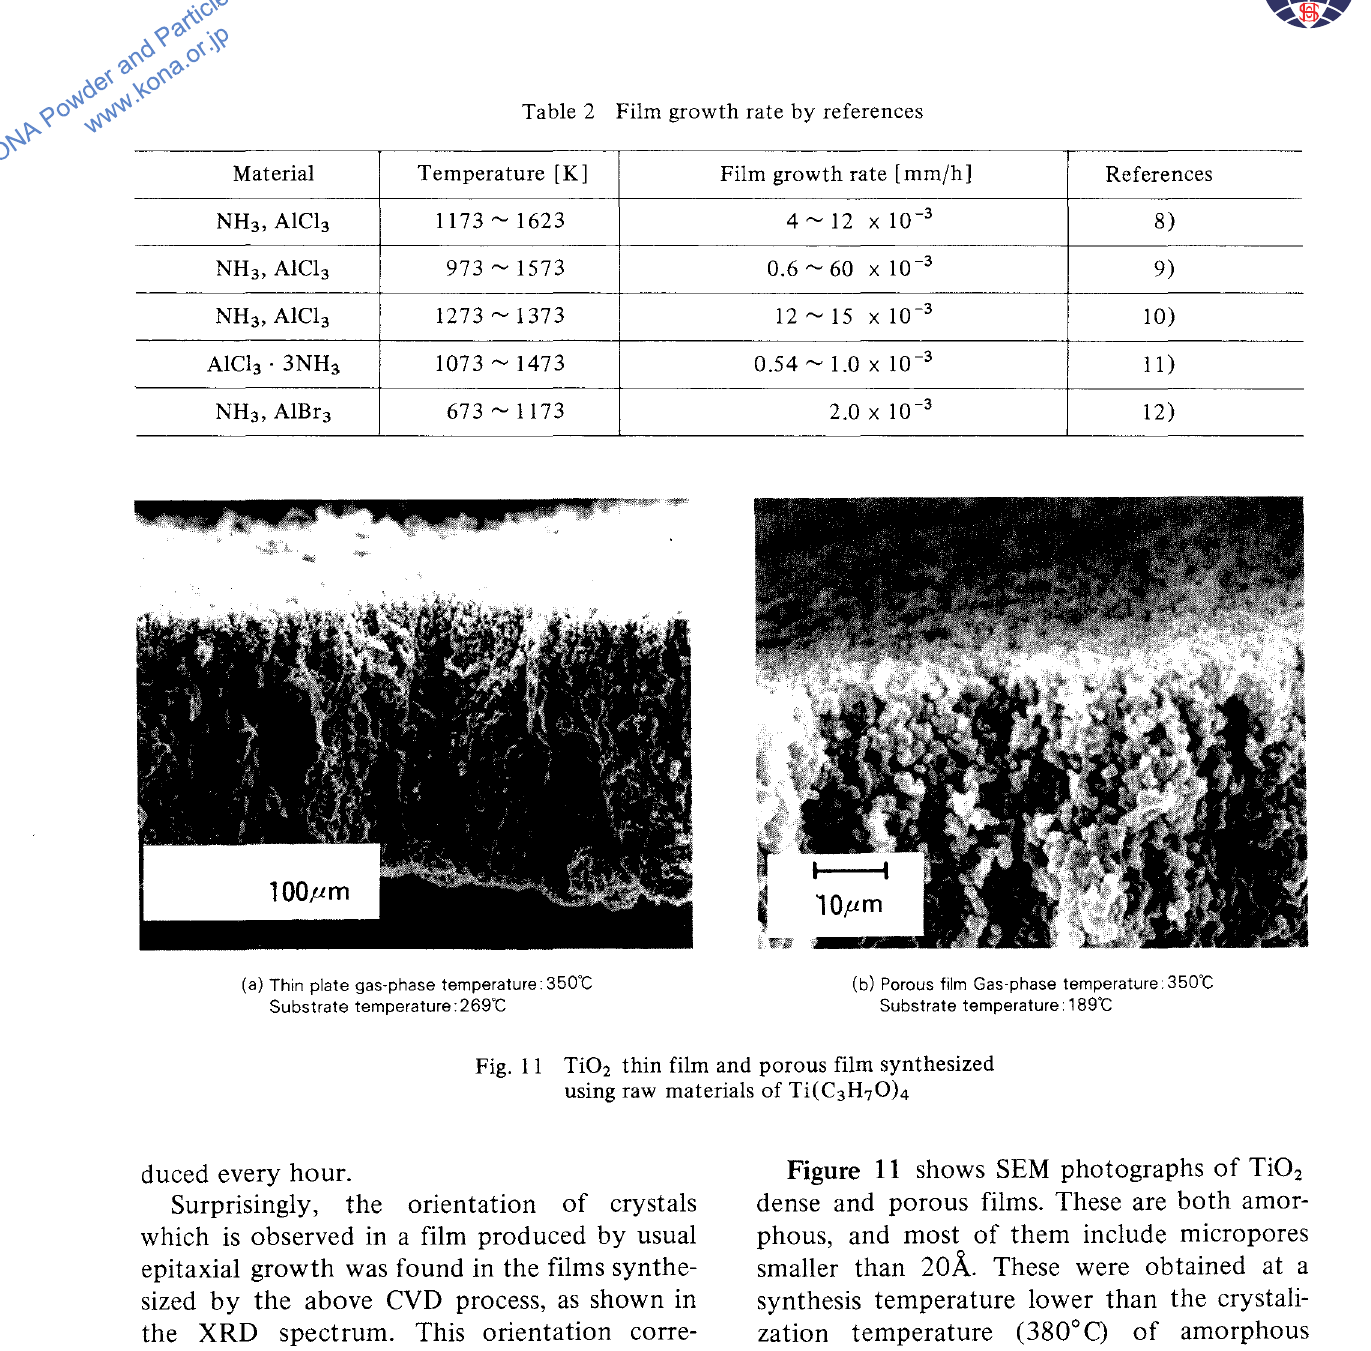
Table 2 Film growth rate by references